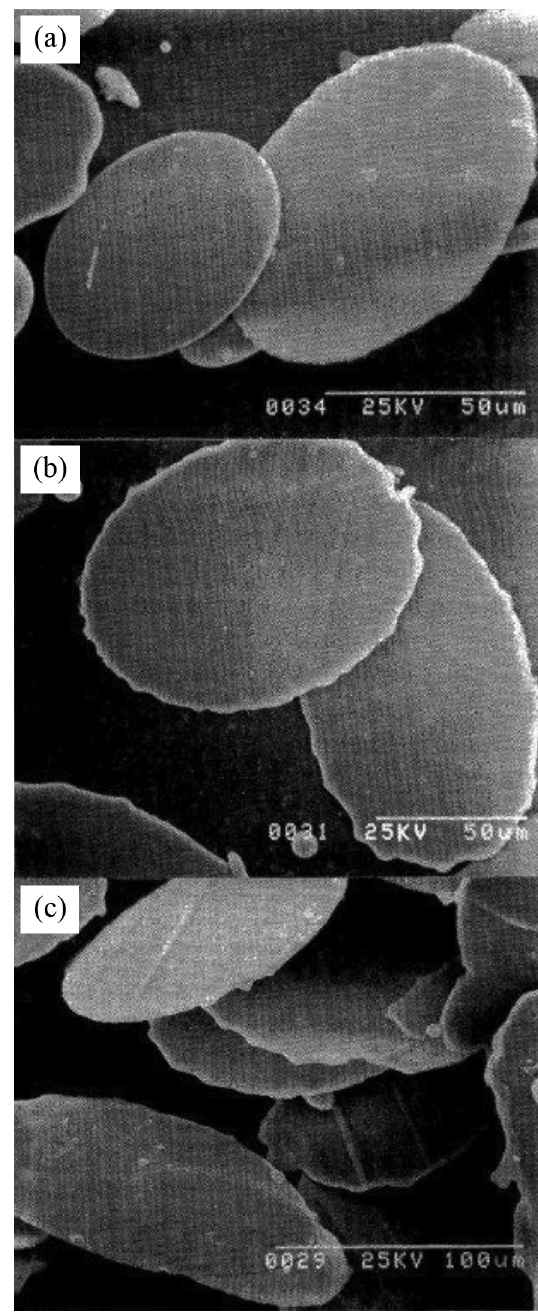
Figure 5. Scanning electron micrographs revealing effect of size fraction on morphology in Al two-stage quenching method. (a) 25 to 45 μm, (b) 45 to 63 μm, (c) 63 to 75 μm [16]